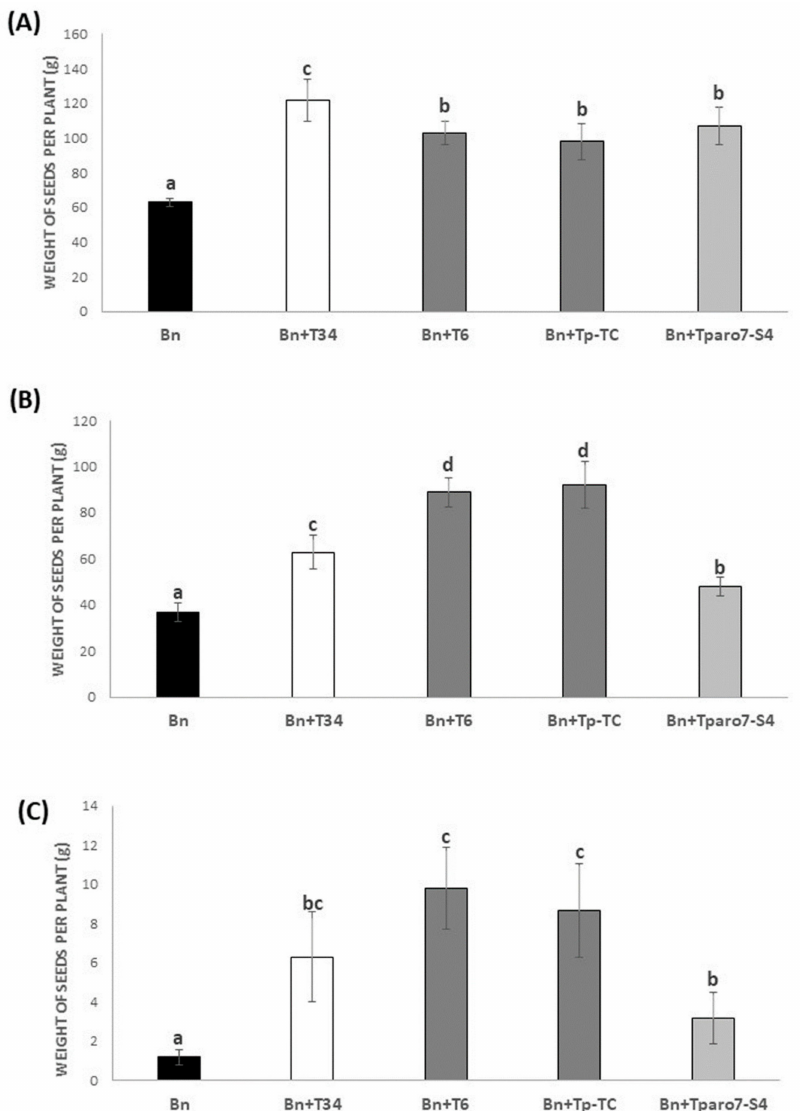
Figure 1. Rapeseed productivity. The weight (g) of the seeds collected from the rapeseed (Bn) and the di ff erent Trichoderma inoculations: T. harzianum ( + T34), T. parareesei ( + T6), T. parareesei transformation control ( + Tp-TC), and the transformant with the silenced Tparo7 gene ( + Tparo7-S4) per plant without stress ( A ), under drought stress ( B ) and under salt stress (NaCl 200mM) ( C ). Data are the mean of three biological replicates for each condition with the corresponding standard deviation, and 15 plants per replicate were used. One-way analysis of variance (ANOVA) was performed, followed by the Tukey’s test. Di ff erent letters represent significant di ff erences ( p <